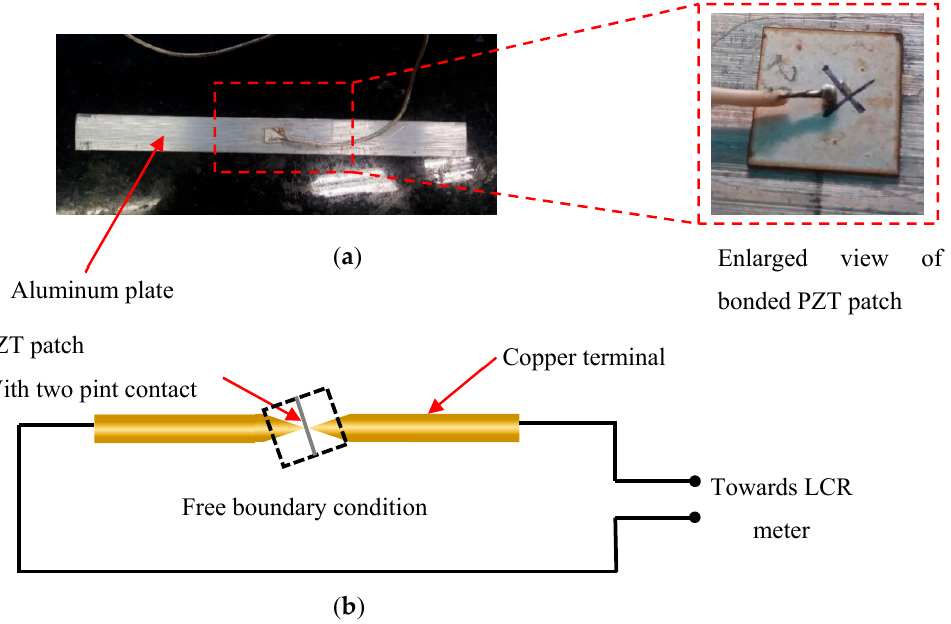
Figure 1. ( a ) Surface-bonded PZT patch on an aluminum plate, ( b ) free PZT patch setup for acquiring free piezo signatures.